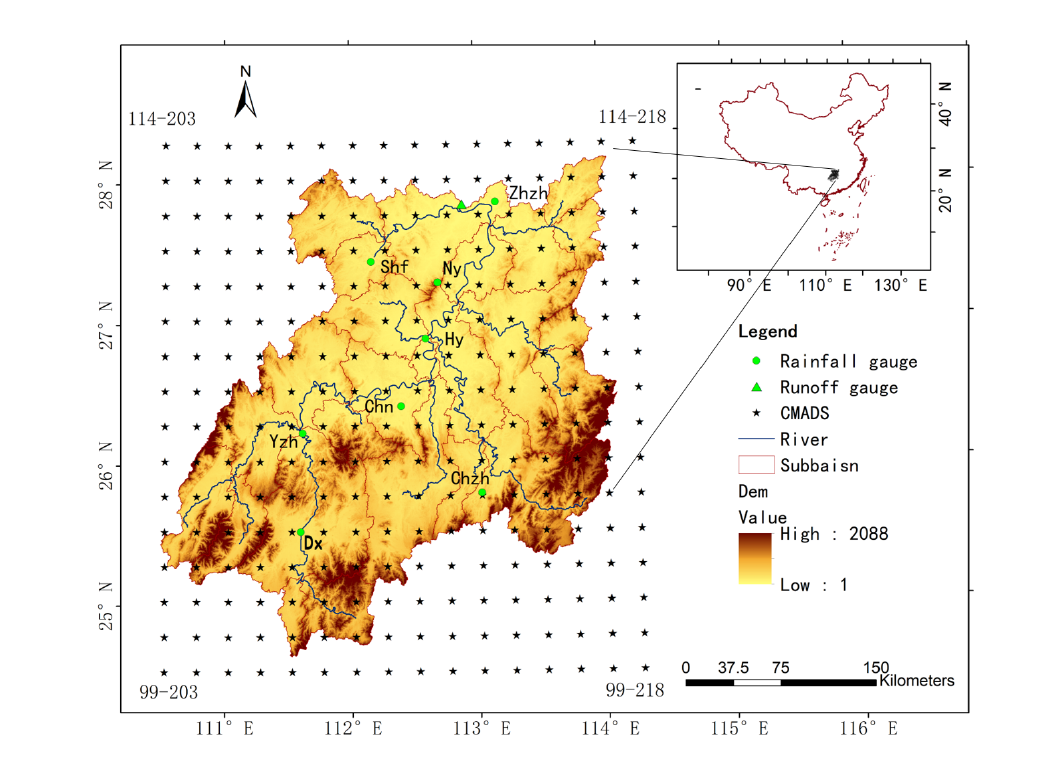
Figure 1. Spatial distribution of CMADS, precipitation gauge stations, and runoff stations in the Xiang River basin with elevations and subbasin divisions (Zhzh represents Zhuzhou site, Shf represents Shuangfeng site, Ny represents Nanyue site, Hy represents Hengyang site, Chn represents Changning site, Yzh represents Yongzhou site, Chzh represents Chenzhou site, and Dx represents Daoxian site, the site after is denoted by the above